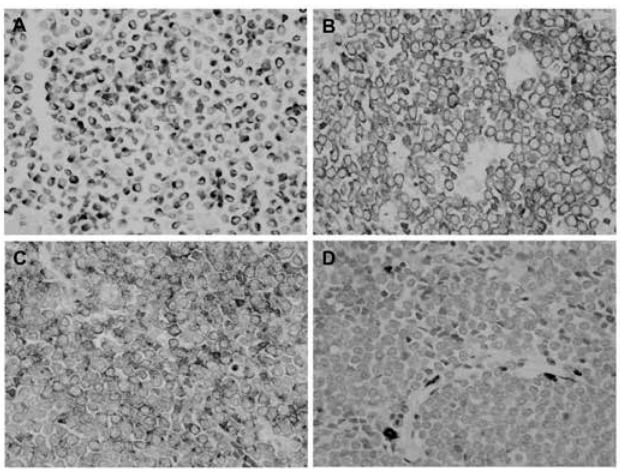
figurE 2 – Immunohistochemical staining of biomarkers used in the diagnosis of MCC: A) positive for cytokeratin 20 (clone KS20.8); B) positive for synaptophysin (clone SY38); C) positive for chromogranin A (clone DAK-A3); D) negative for T-cell receptor-CD3 (epsilon chain) (polyclonal) MCC: Merkel cell carcinoma.